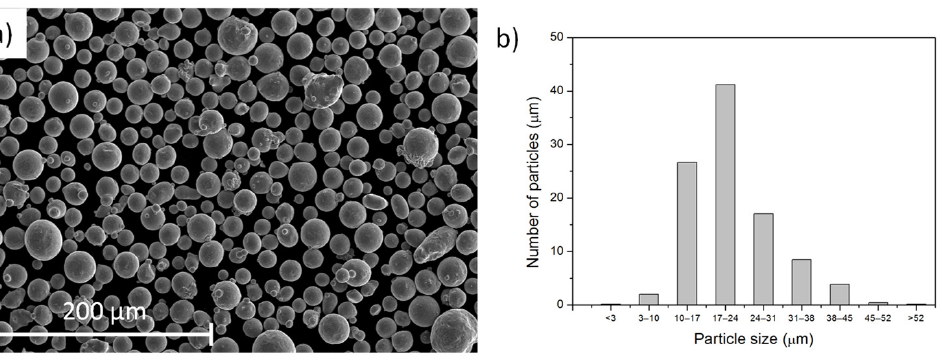
Figure 1. ( a ) SEM image of the 316L powder used; ( b ) histogram of particles size.